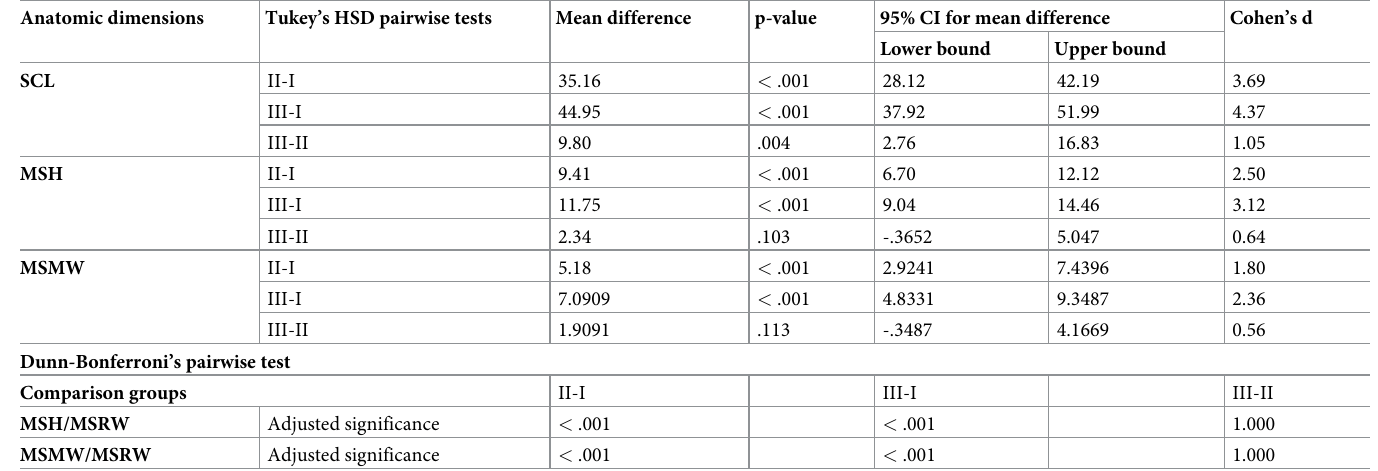
Table 4. Pair-wise multiple